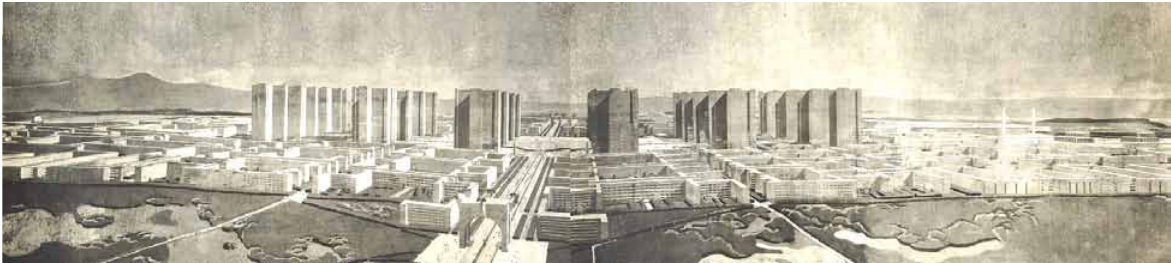
fig. 3. Diorama of Contemporary City for Three Million Inhabitants. l3-20-(2-4) ©